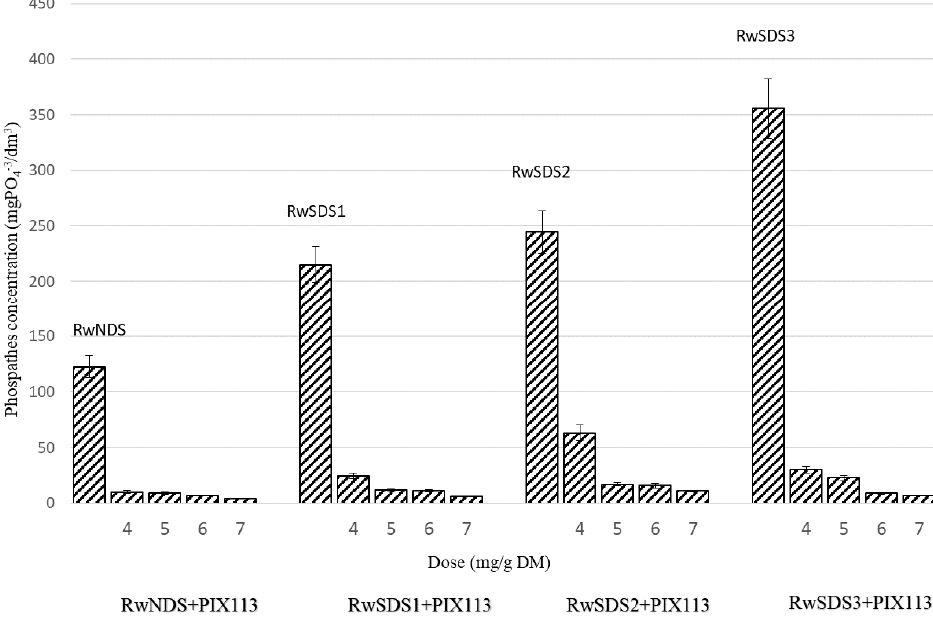
Figure 4. Changes of the phosphate concentration in the reject water separated from sludge prepared with PIX 113.